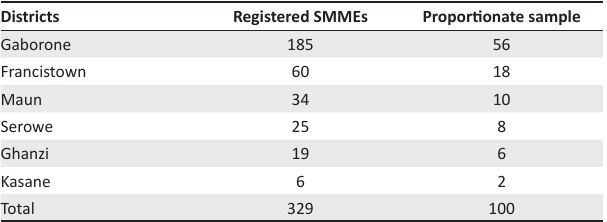
TABLE 3: Sampling for manufacturing small, medium and micro-sized